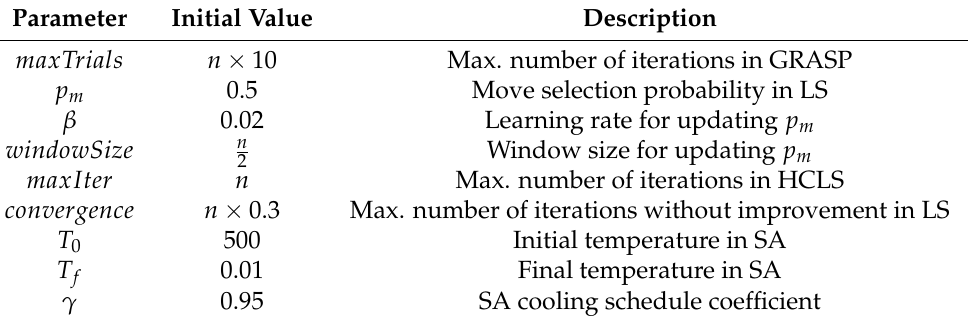
Table 1. Algorithm parameter